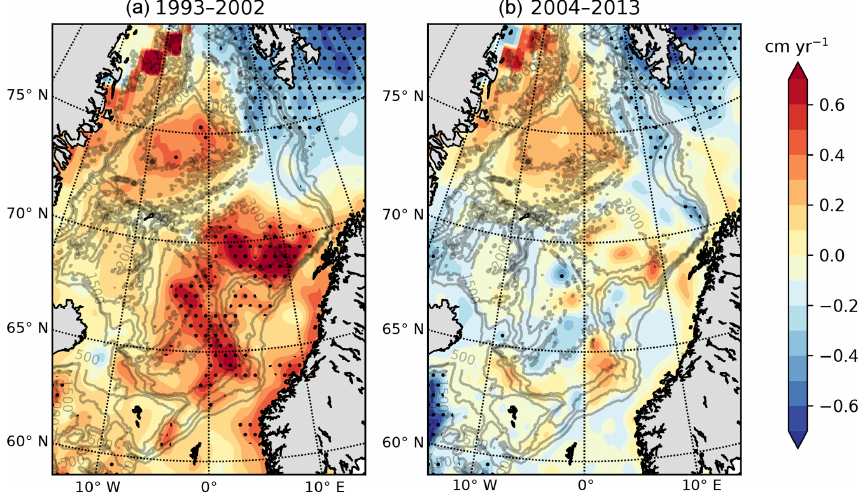
Figure 3. Linear trend in SSH (cmyr − 1 ) for (a) 1993–2002 and (b) 2004–2013. A global trend for the full altimetry period 1993–2017 has been removed from the data. Dotted areas are significant at a 95% confidence level, determined using the two-sided hypothesis Wald test with t distribution (Oliphant, 2007). Grey contours are bathymetry (Becker et al.,